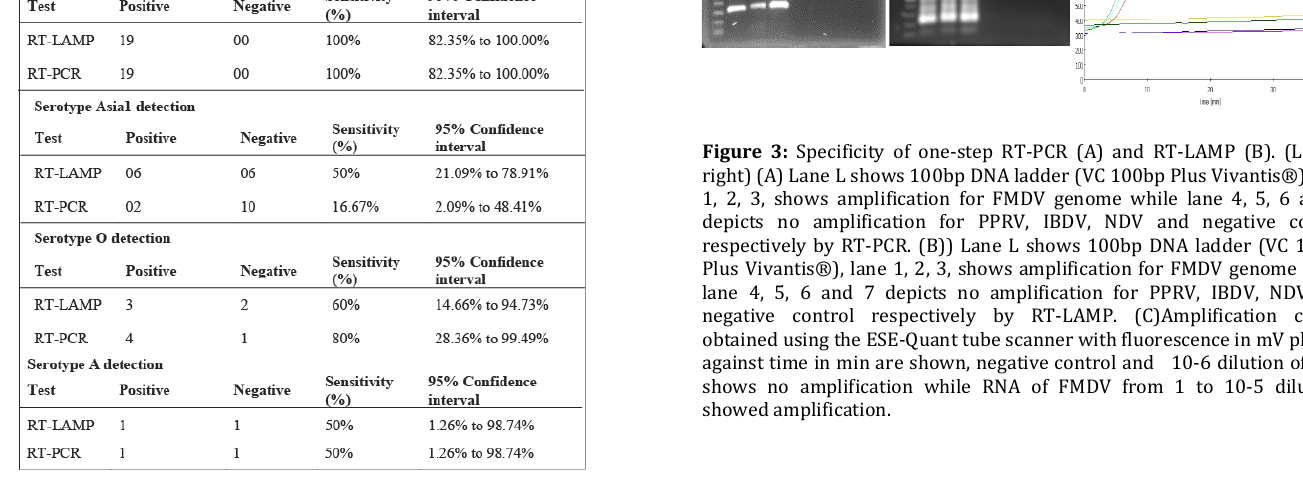
Figure 2: Sensitivity of one step RT-PCR (A) and RT-LAMP (B and C). (Left to right) (A) Lane L shows 100bp DNA ladder (VC 100bp PlusVivantis®), while lane 1, 2, 3, 4, 5, 6, 7 and 8 depicts the amplification of 1, 10-1, 10-2, 10-3, 10-4, 10-5, 10-6dilutions of RNA and negative control respectively using one step RT-PCR for FMDV. (B) Lane L shows 100bp DNA ladder (VC 100bp Plus Vivantis®), lane 1 negative control, while lane 2, 3, 4, 5, 6, 7 and 8 depicts the amplification of 1, 10-1, 10-2, 10-3, 10-4, 10-5 and 10-6 dilutions of RNA for FMDV respectively by RT-LAMP. (C) Amplification curves obtained usingthe ESE-Quant tube scanner with fluorescence in mV plotted against time in min are shown, negative control and 10-6dilution of RNA shows no amplification while RNA of FMDV from 1 to 10-5dilutions show amplification. 3.3 Sensitivity